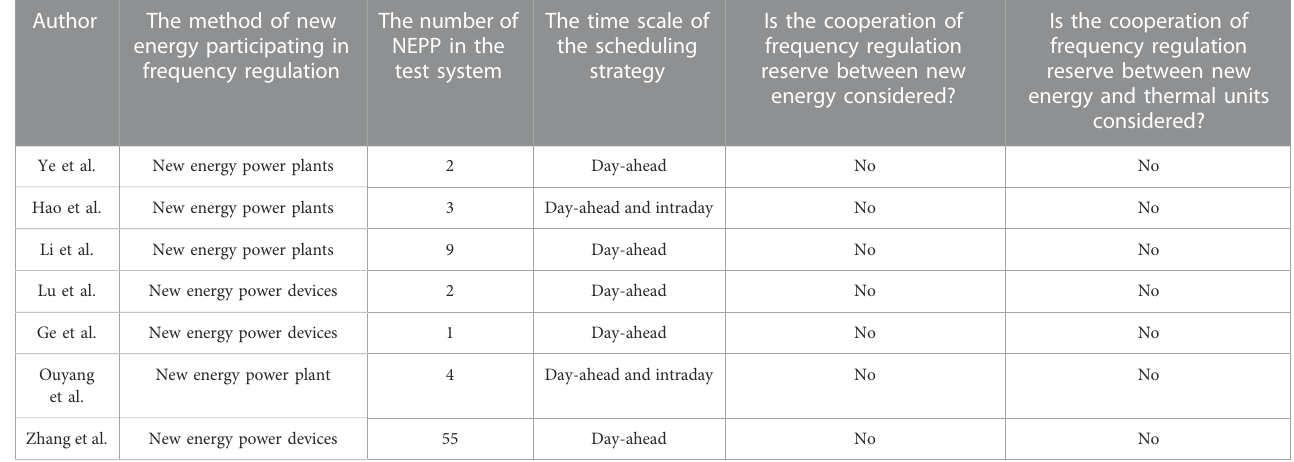
TABLE 1 Comparison of existing power system dispatching strategies, considering new energy participating frequency